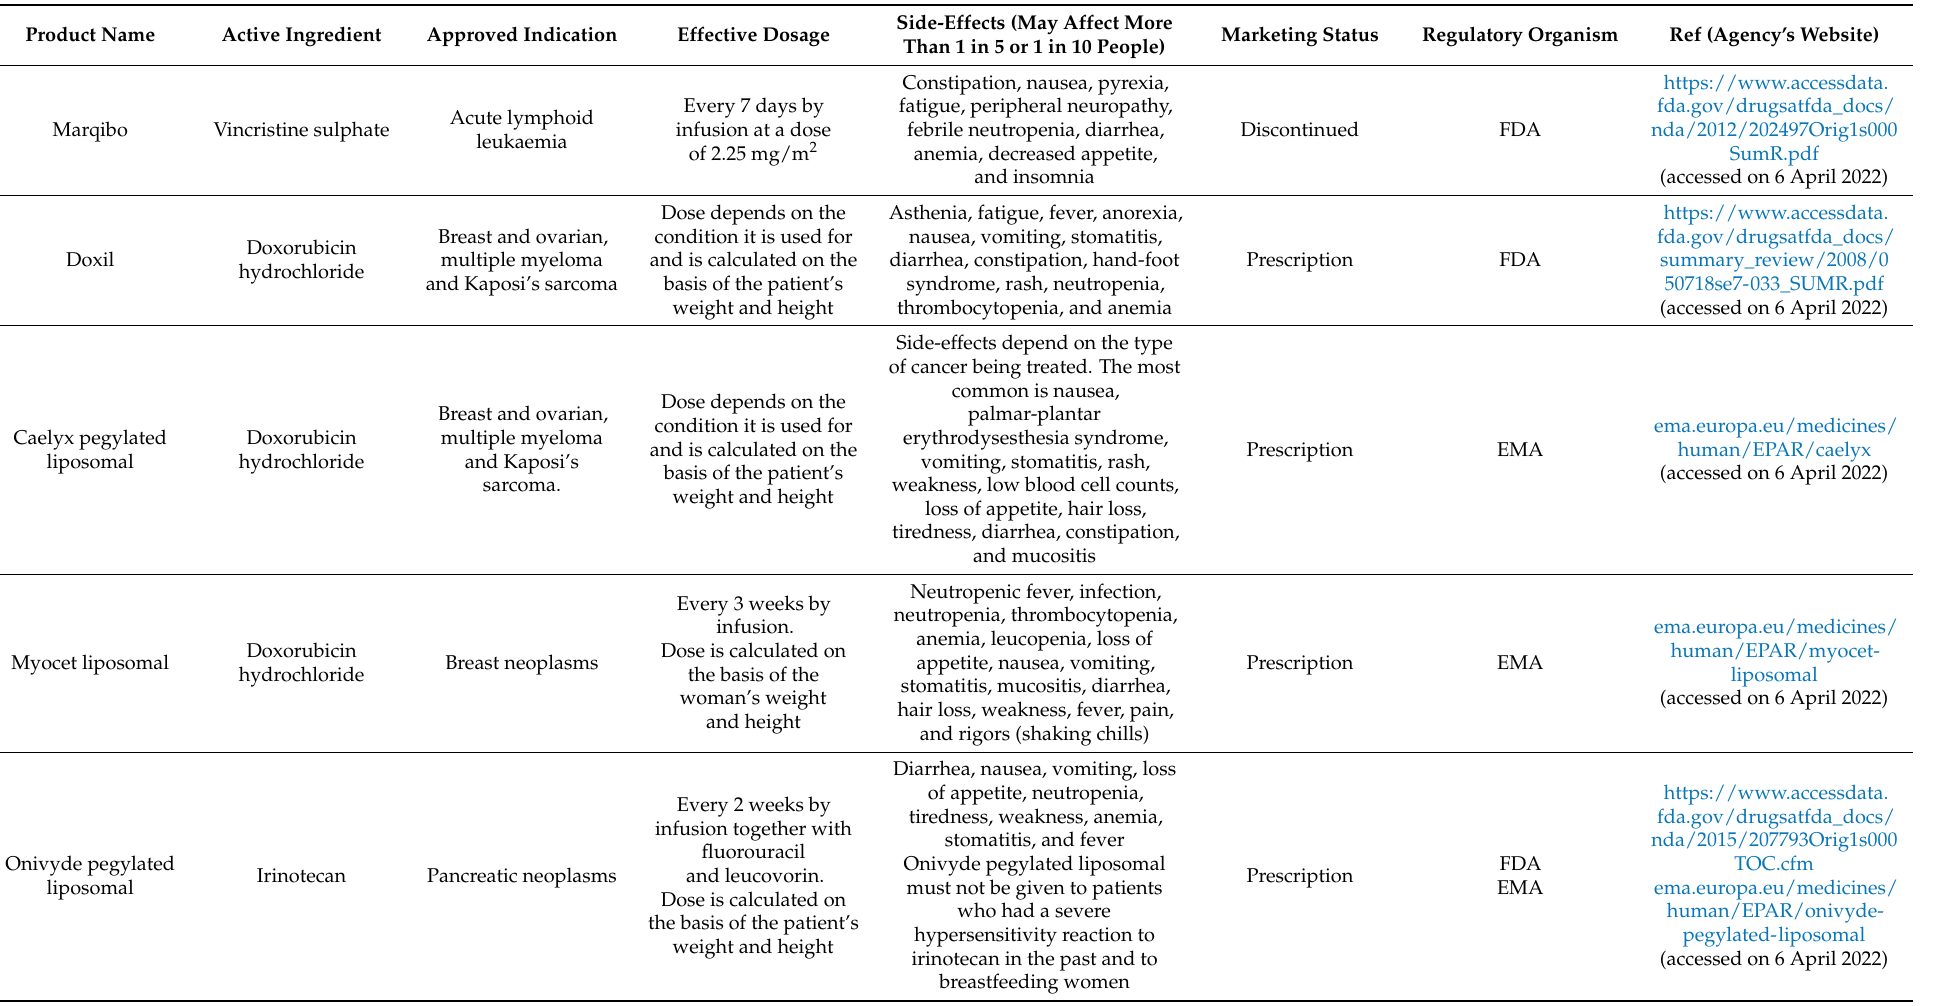
Table 1. Liposome-based products marketed for cancer